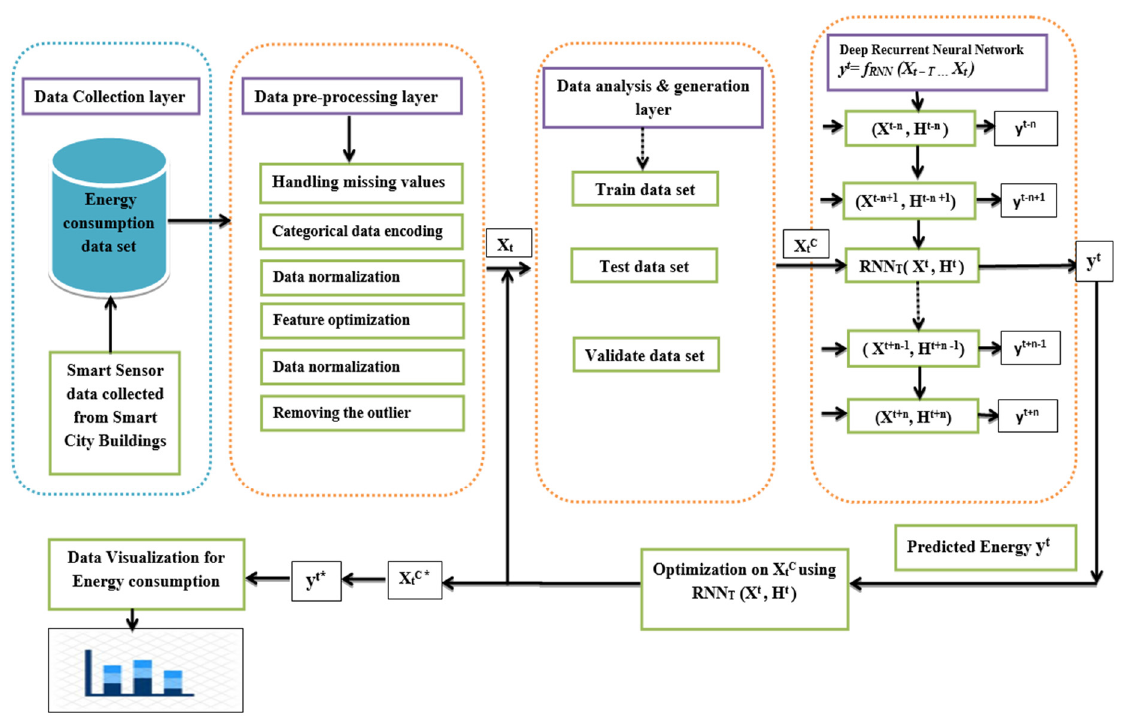
Figure 11. A deep neural network-enabled energy consumption model for smart city buildings.